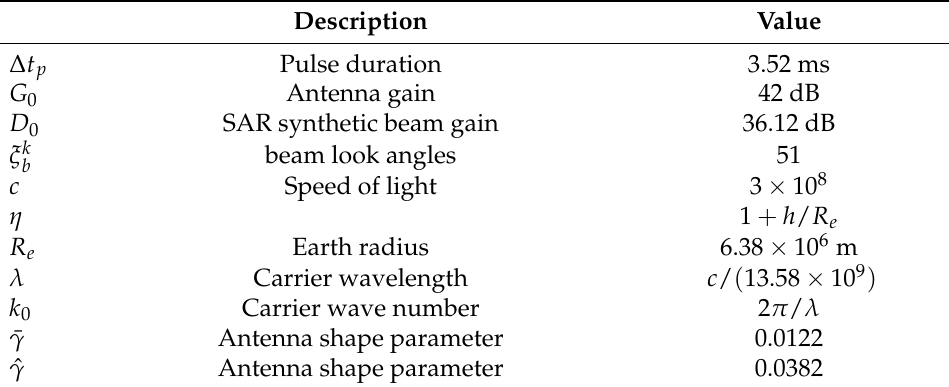
Table 2. Parameter values for the semi-analytical